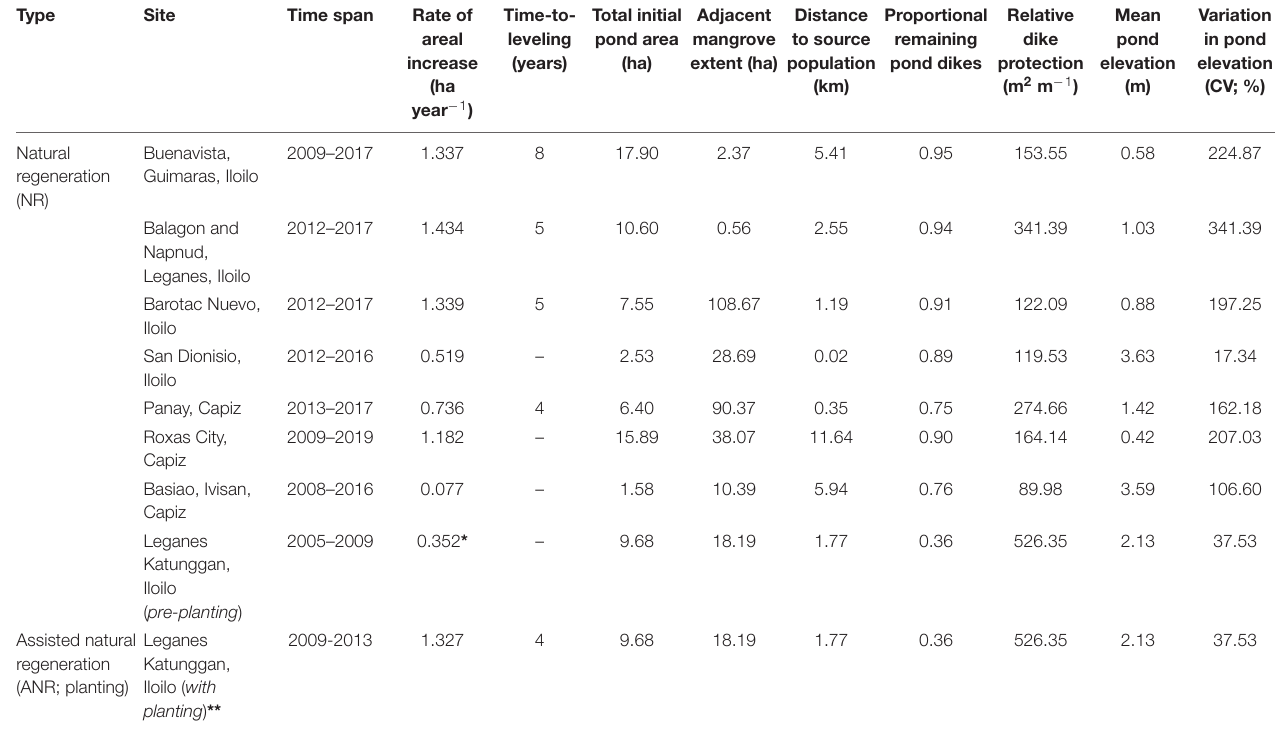
TABLE 2 | Summary statistics for “rate of areal increase” and “time-to-leveling” and proxies of potential drivers of regeneration speed for all abandoned aquaculture ponds considered in this study.